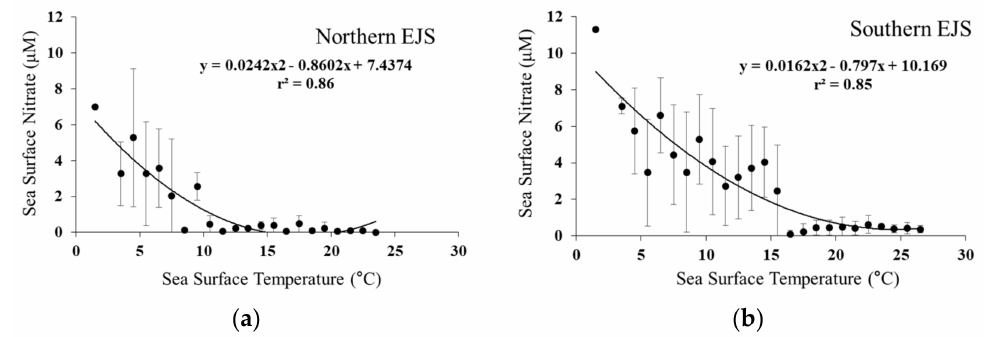
Figure 2. Relationships between Sea Surface Nitrate (SSN) and Sea Surface Temperature (SST) in the northern ( a ) and southern ( b ) East/Japan Sea.